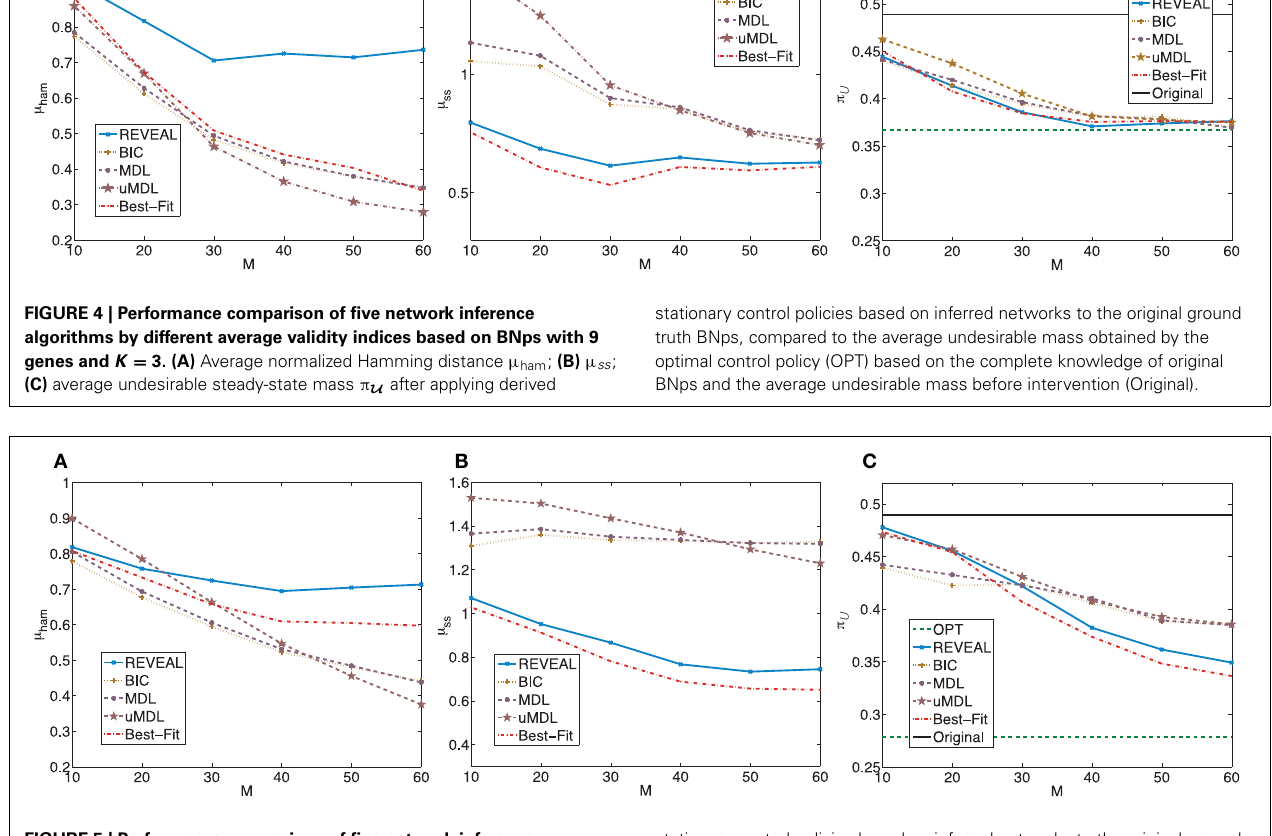
stationary control policies based on inferred networks to the original ground truth BNps, compared to the average undesirable mass obtained by the optimal control policy (OPT) based on the complete knowledge of original BNps and the average undesirable mass before intervention (Original).